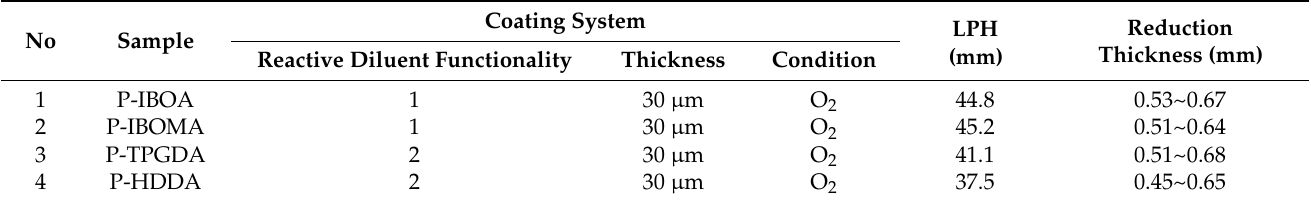
Table 3. LPH & Reduction thickness by Cross-die cup drawing for UV-cured PUA coating